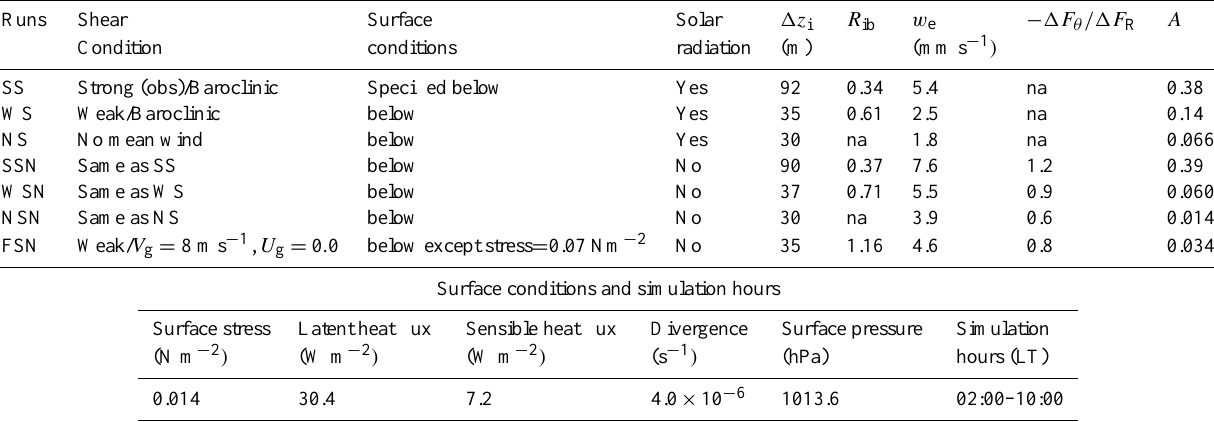
Table 1. Simulation conditions and results based on last 3h